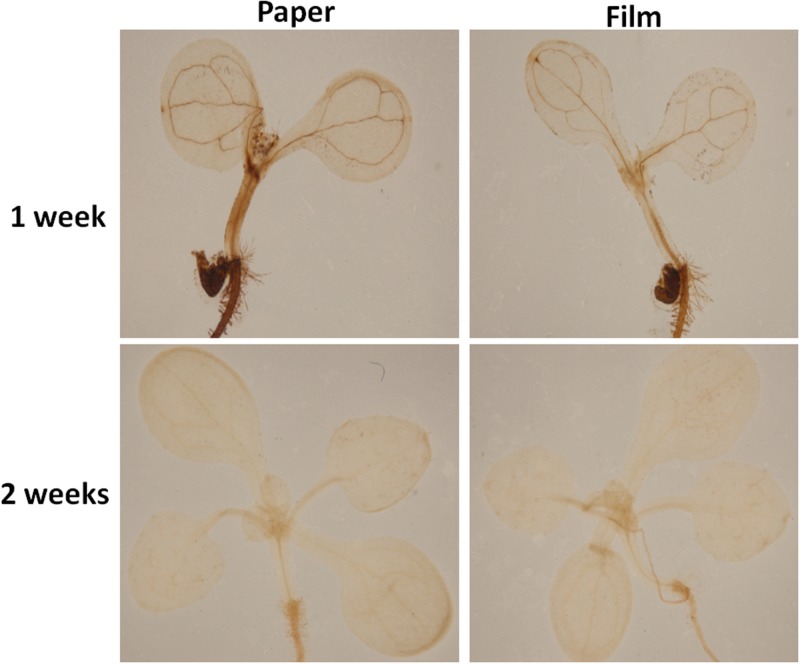
H2O2 accumulation in Col seedlings after 1 and 2 weeks of growth measured using DAB solution staining. DAB is oxidized by hydrogen peroxide in a reaction typically catalyzed by horseradish peroxidase (HRP). The oxidized DAB forms a brown precipitate, at the location of the HRP, which can be visualized using light microscopy. All seedlings were grown on standard MS media with sucrose shown in section “Materials and Methods”. One (of six) typical seedlings is shown for every treatment. The experiment was repeated twice with similar results.